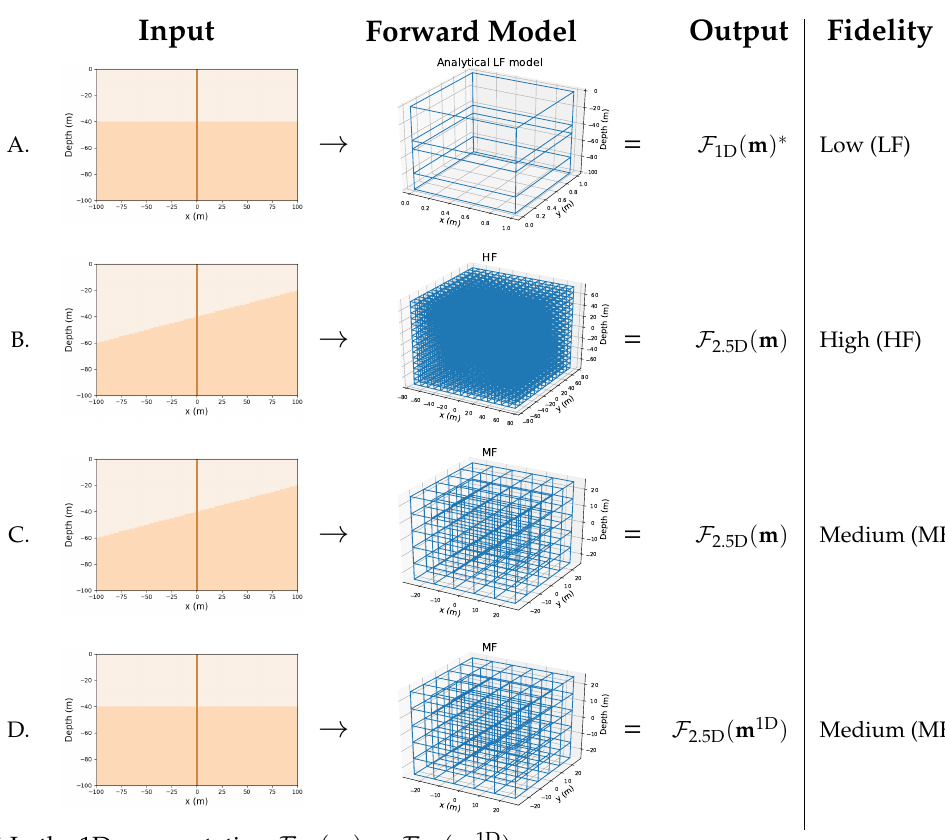
Figure 1. Conceptual visualization of the various forward data types used. The input is either a multidimensional subsurface model ( B , C ) or a 1D subsurface model (in a moving footprint approach) ( A , D ). The forward model is either a Low-Fidelity (LF) analytical forward model (with depths and EC as input) (see A ), a High-Fidelity (HF) forward simulation on an accurate mesh ( B ) or a Medium- Fidelity (MF) forward simulation on an inaccurate (coarser) mesh ( C , D ). NOTE: the presented meshes are illustrative and are not the ones used for multidimensional modeling. Some details on the MF and HF mesh are described in Appendix